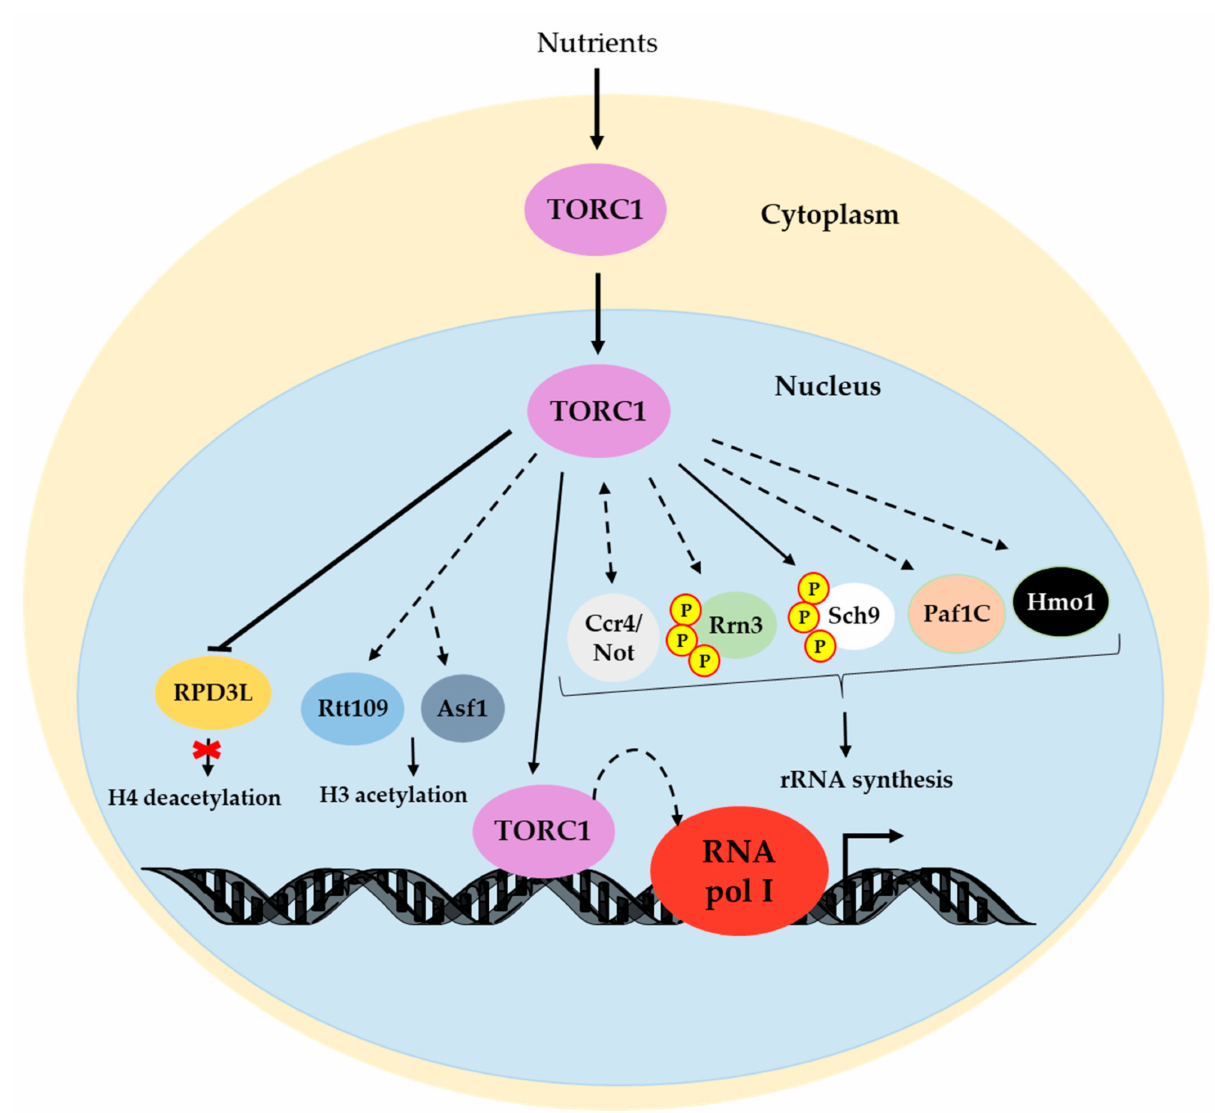
Figure 1. Regulatory network from TORC1 to RNA pol I transcription. Under nutrient-rich conditions, TORC1 localizes in the nucleus and also associates with chromatin to possibly favor transcription [30]. TOR regulates histone modification by regulating Asf1 and Rtt109 positively and RPD3L nega- tively [68,69]. Nuclear TOR also promotes the Rrn3-RNA pol I interaction [13,41] and indirectly influences RNA pol I transcription through Sch9 [40], Paf1C [62], Hmo1 [51] and Ccr4/Not [59]. Note that bidirectional arrows are represented in the last case due to crosstalk between that element and TOR [55]. Solid lines denote direct positive regulation. Dotted lines depict indirect positive regulation. Bars refer to negative regulation. Details for each mechanism are provided in the text. TORC1 associated with chromatin corresponds to Tor1 and Kog1